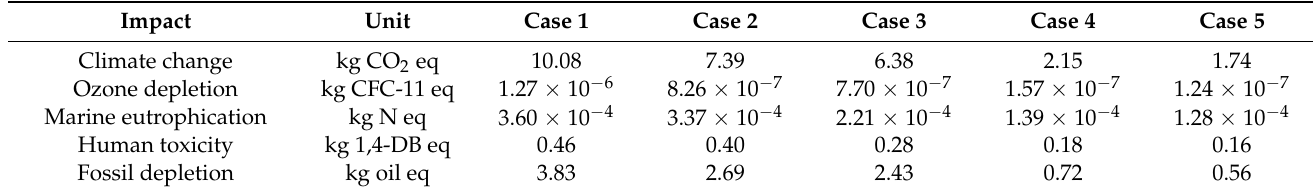
Figure 12. The impacts of desalination plants of cases 1 to 5 on ( A ) climate change, ( B ) ozone depletion, ( C ) marine eutrophication, ( D ) human toxicity, and ( E ) fossil depletion. Table 5. Midpoint environmental indicator values for cases